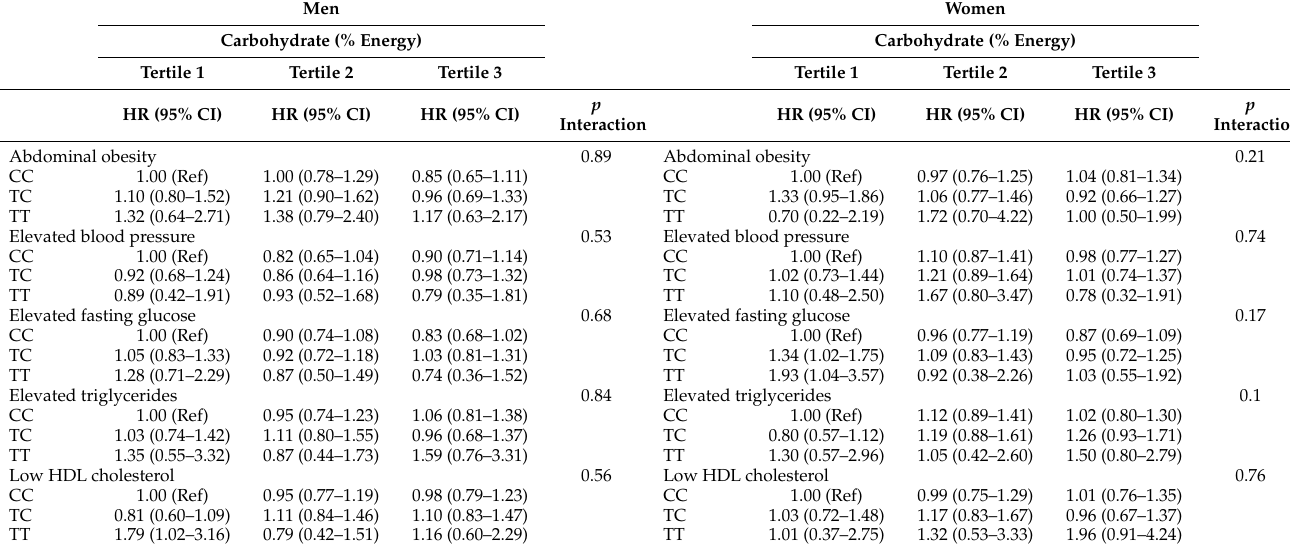
Table 8. Adjusted hazard ratios (HRs) and 95% confidence intervals (CIs) of metabolic syndrome components incidence depending on the genotype of SLC35F3 rs10910387 by carbohydrate